Question: Provide a one-line summary of what is displayed.
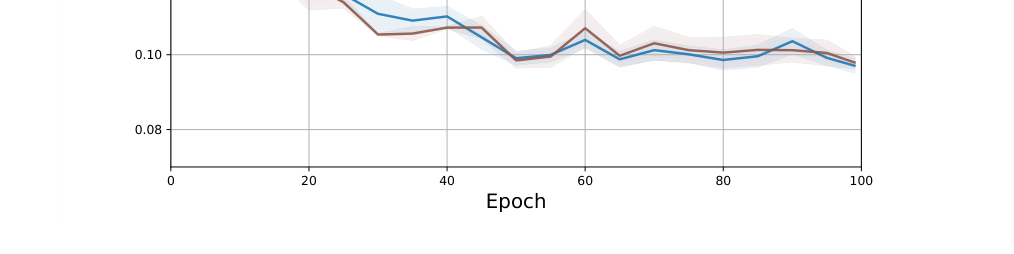
Answer: Test L2 error curves for GINO on the Ahmed-body CFD dataset on three random seeds and standard deviation as error bars.